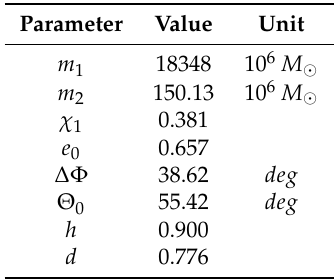
Table 2. Parameters of the orbit solution [9]. ©AAS